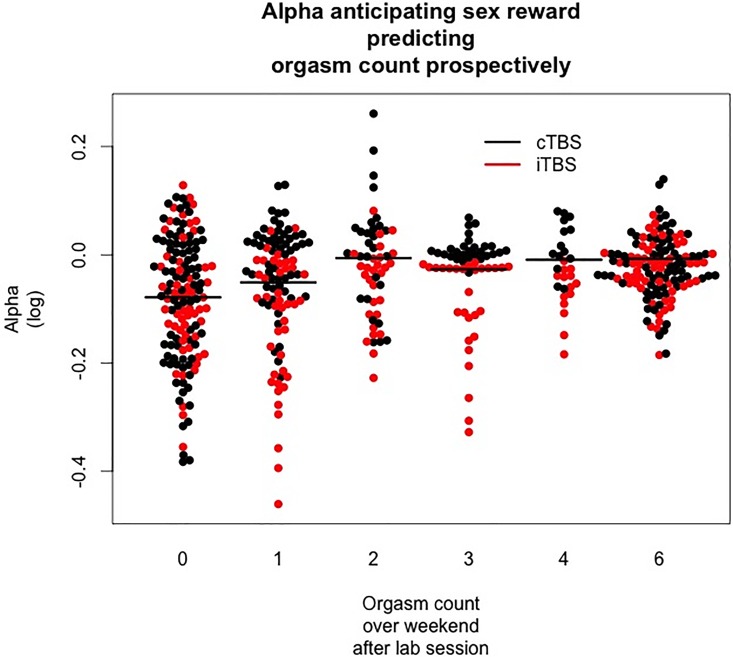
Prediction of orgasm count over the coming Friday, Saturday, and Sunday by EEG alpha in anticipation of sex reward (both brain stimulation conditions included).The plot reflects the ordinal assumptions of conditional logit models (CLM). CLM do not require interval spacing, only that each “level of orgasm” be ordered For example, no value of 5 exists because no one reported 5 orgasms, and each logit is calculated only relative to the next value in the ordered list of orgasm counts.